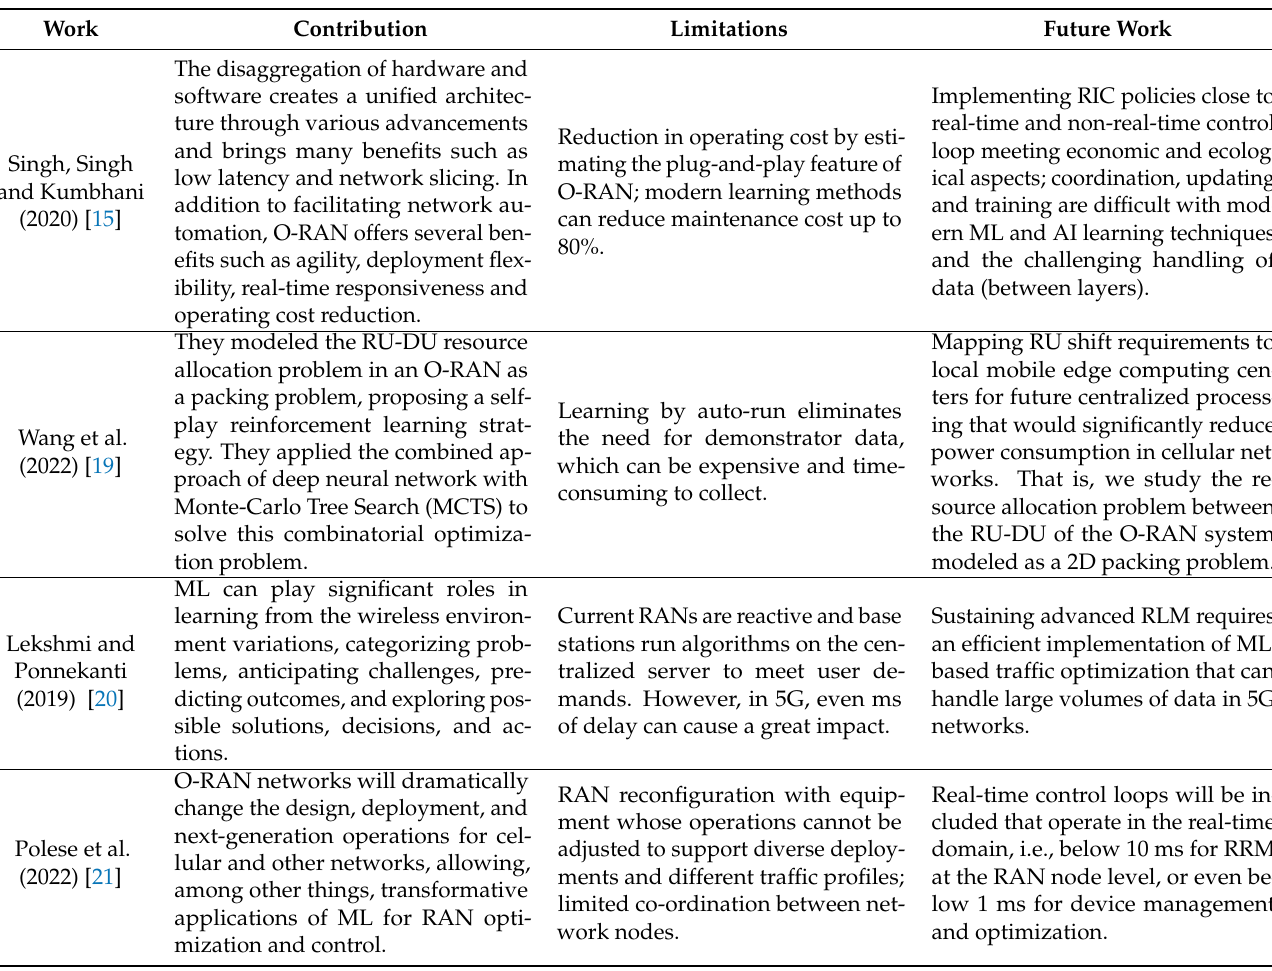
Table 1. Summary of related